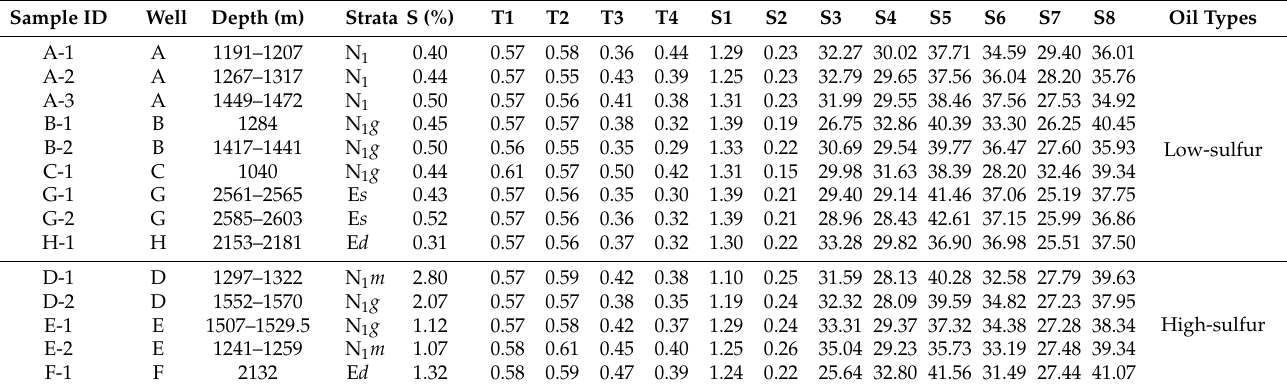
Table 1. Basic information and geochemical parameters based on the steranes and terpanes in the studied oil